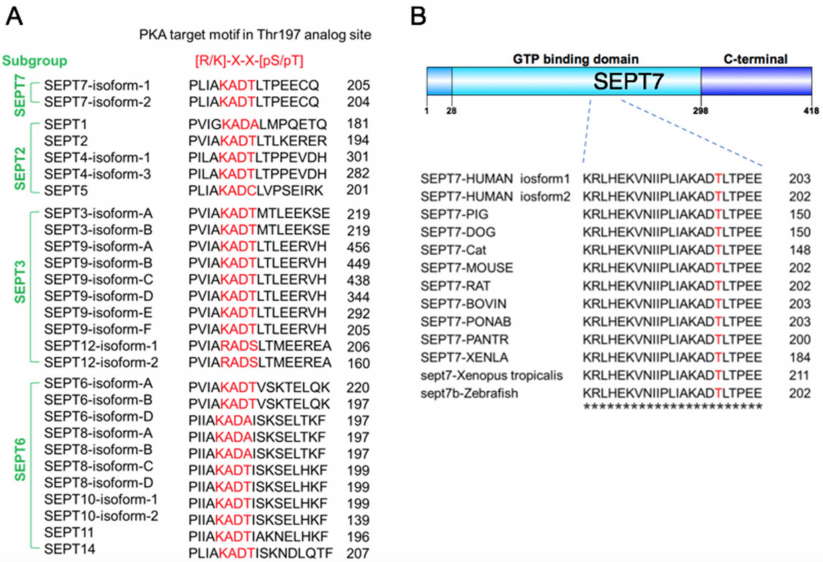
Figure 1. Conservation of PKA target SEPT7 phosphorylation site Thr197 among species. ( A ) Multiple sequence alignment flanking the analogous Thr197 residue of SEPT7 in 13 different human genes coding for septins. Alignment of the sequences is according to the PKA consensus target motif [R/K]- X-X-[pS/T]. ( B ) Multiple sequence alignment of analogous sites of Thr197 in the SEPT7 orthologues and comparison of the amino acids in various species. Red indicates that the residues’ alignment was similar. At the bottom, the asterisk denotes an identical residue in all sequences in the alignment. The amino acid sequences were analyzed using the ClustalW2 program at